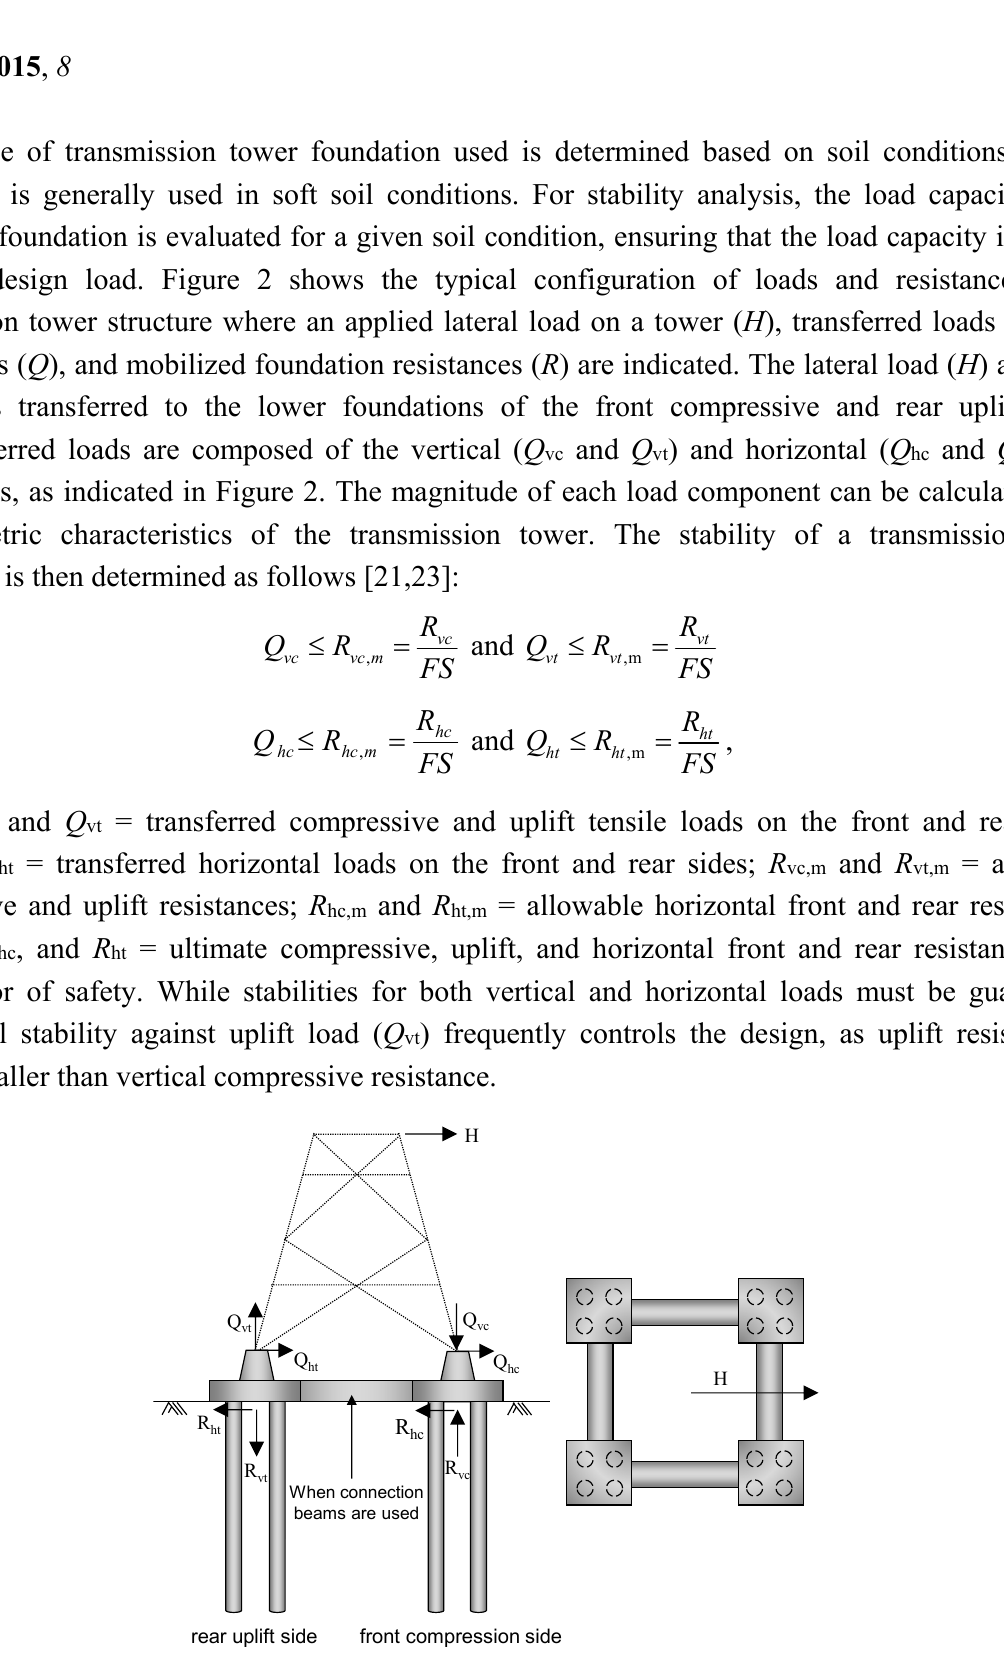
Figure 2. Configurations of loads and resistances for transmission tower